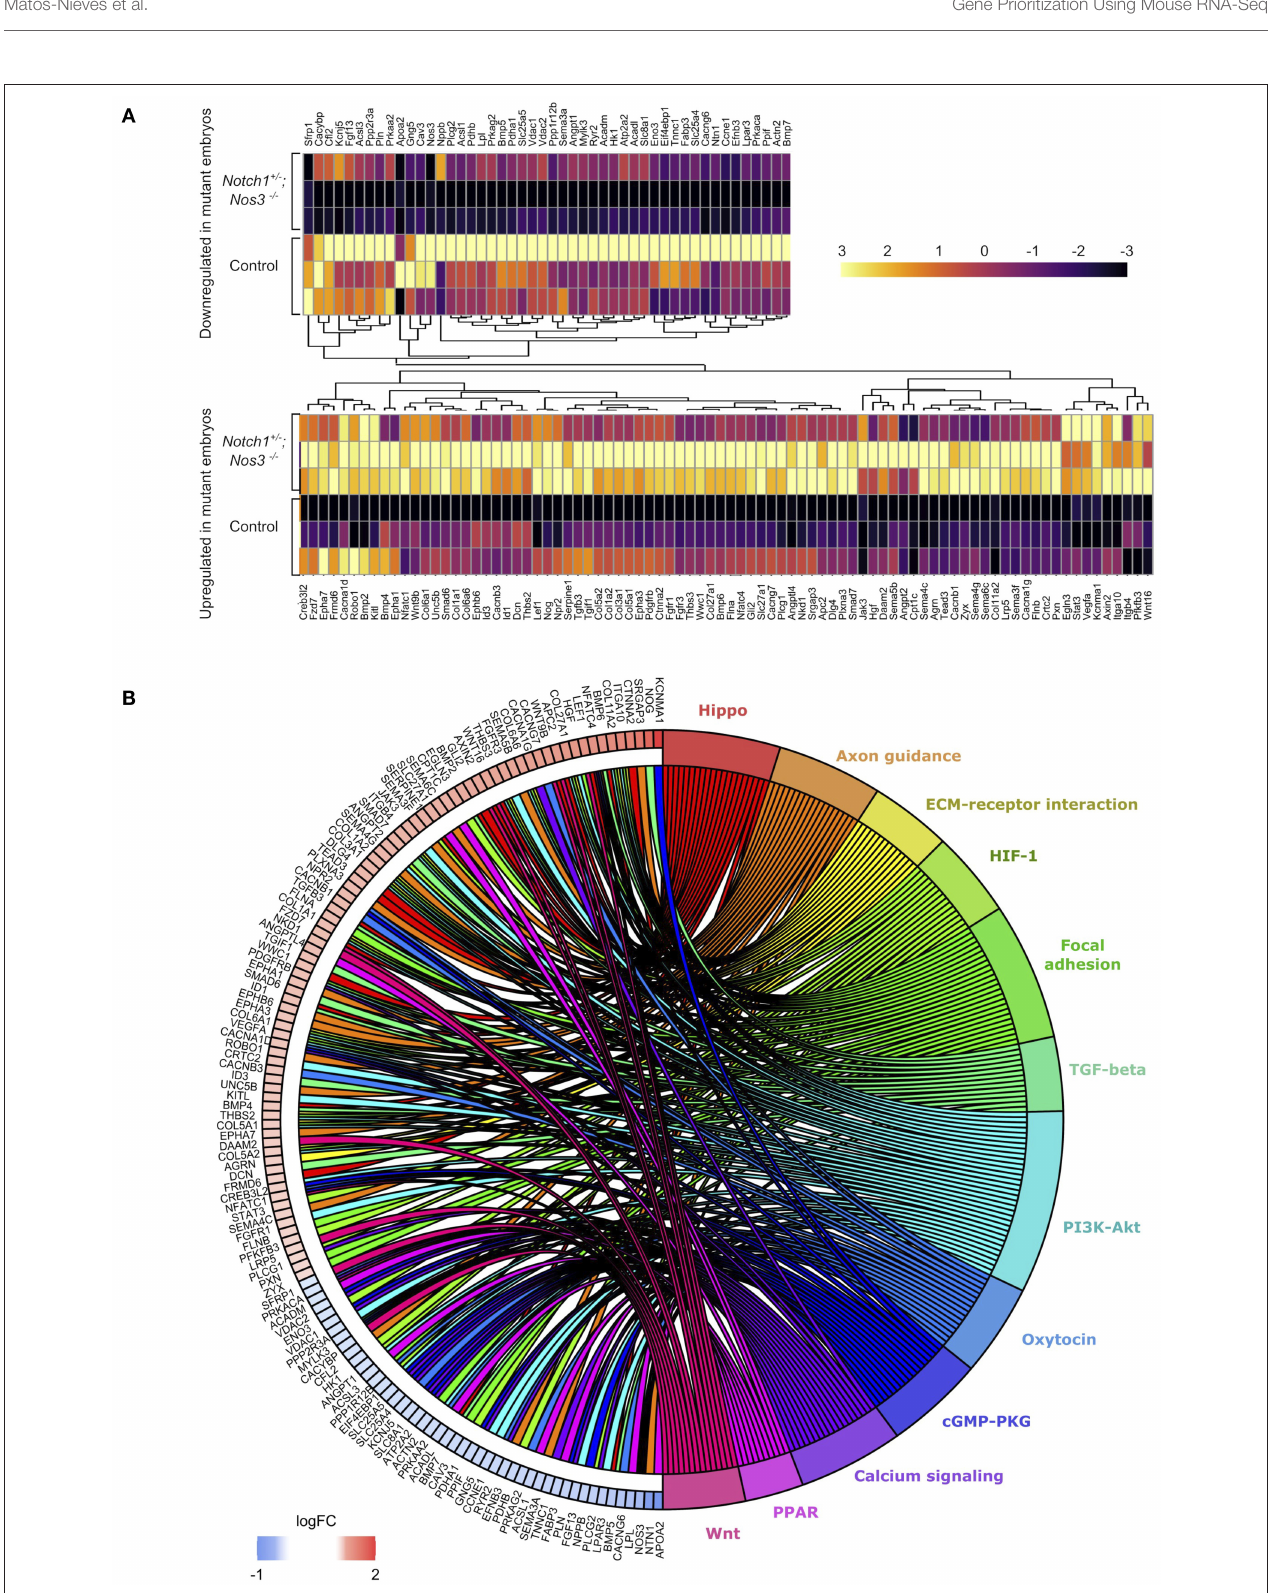
FIGURE 3 | Differential gene expression analysis (DESeq2) shows significant gene expression changes between Notch1 + / − ; Nos3 − / − compound mutants and wildtype (WT) littermate controls. (A) Split hierarchical heatmap cluster show differential gene expression among biological replicates obtained from transcriptomic profiling of Notch1 + / − ; Nos3 − / − compound mutants and wildtype littermate controls for a subset of genes ( n = 3 for each condition). (B) Chord plot shows 132 differentially expressed genes identified in bulk RNA-Seq analysis and predicted signaling pathway associations.